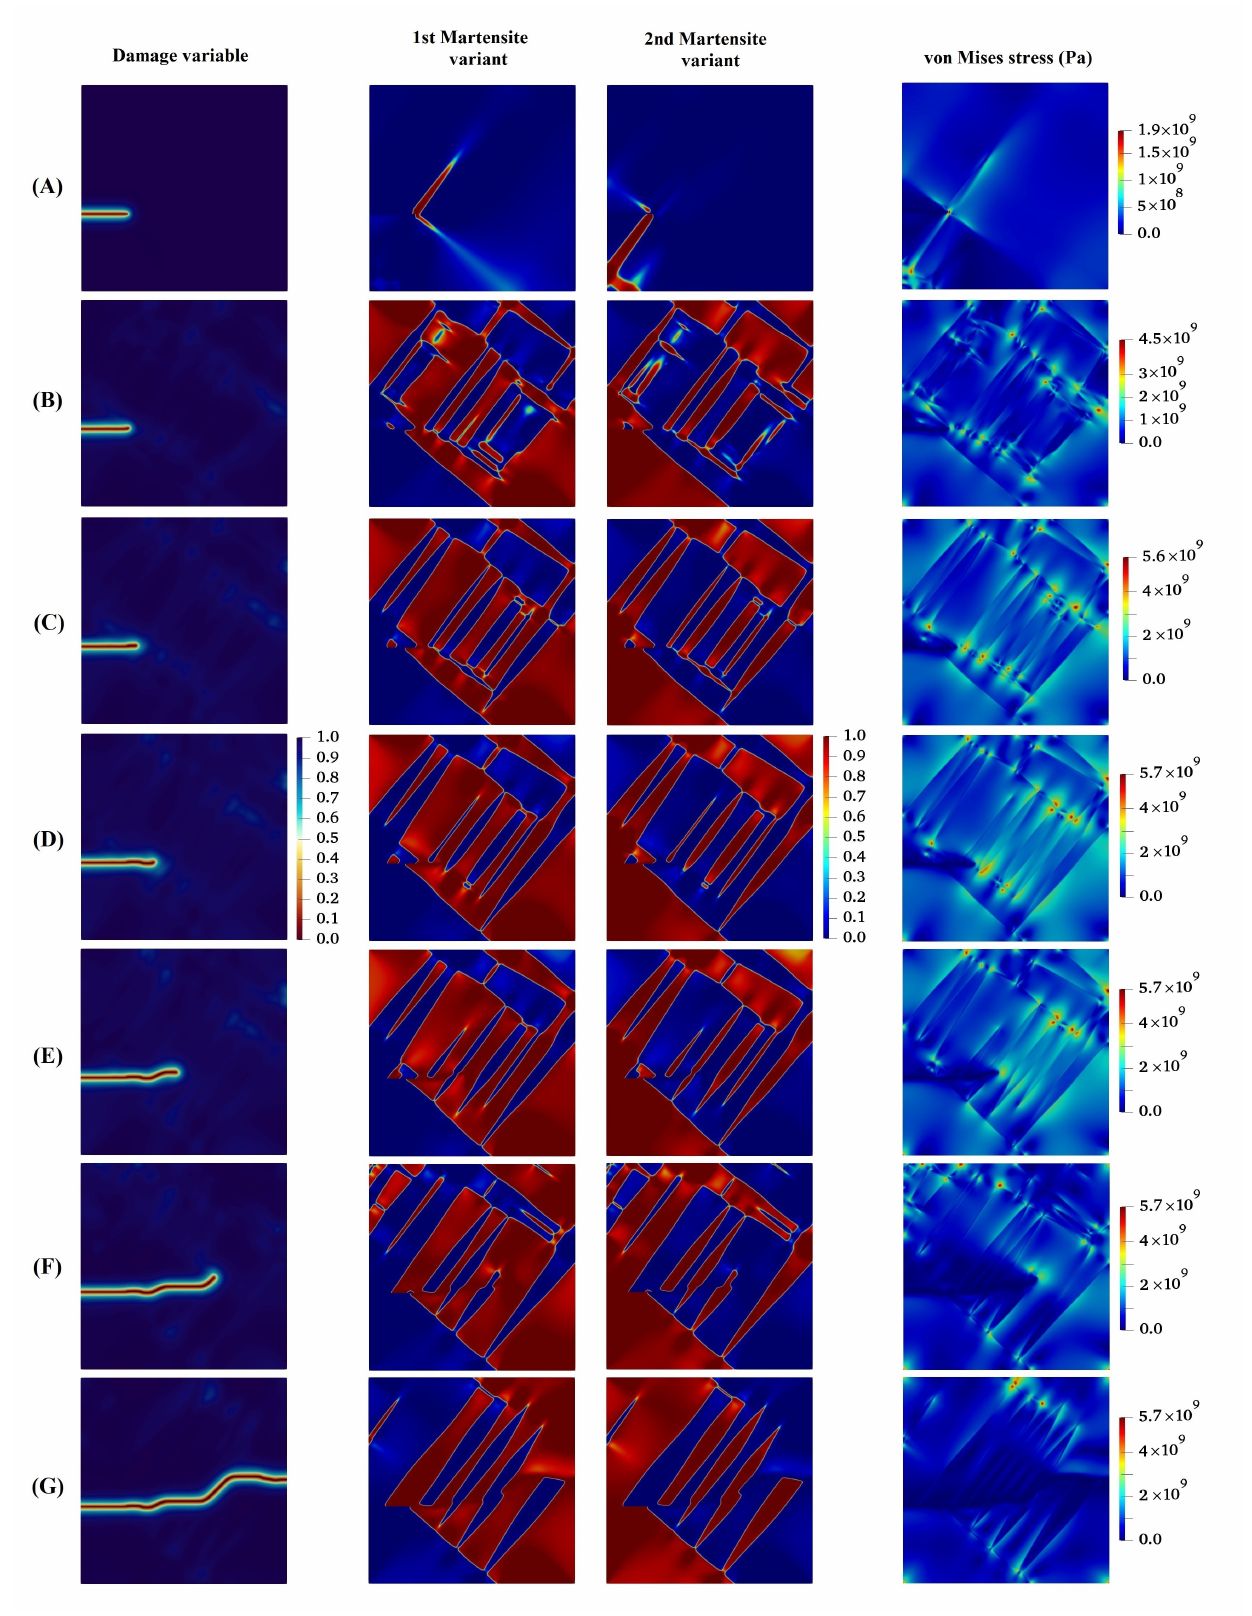
Figure 9. Evolution of damage variable, two martensite variants, and von Mises stress in the austenitic microstructure under Mode I loading with crystal lattice orientation of 60°